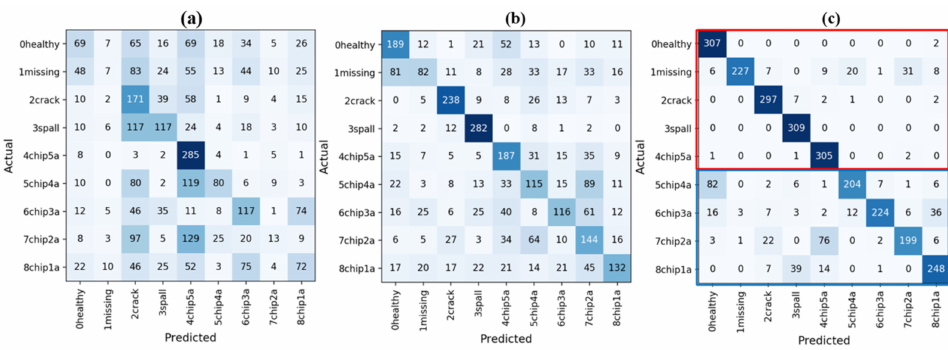
Figure 9. Confusion matrices of the three transfer schemes ( a ) TFS; ( b ) TFI; ( c ) TFC, when the splitting ratio of training/testing samples is